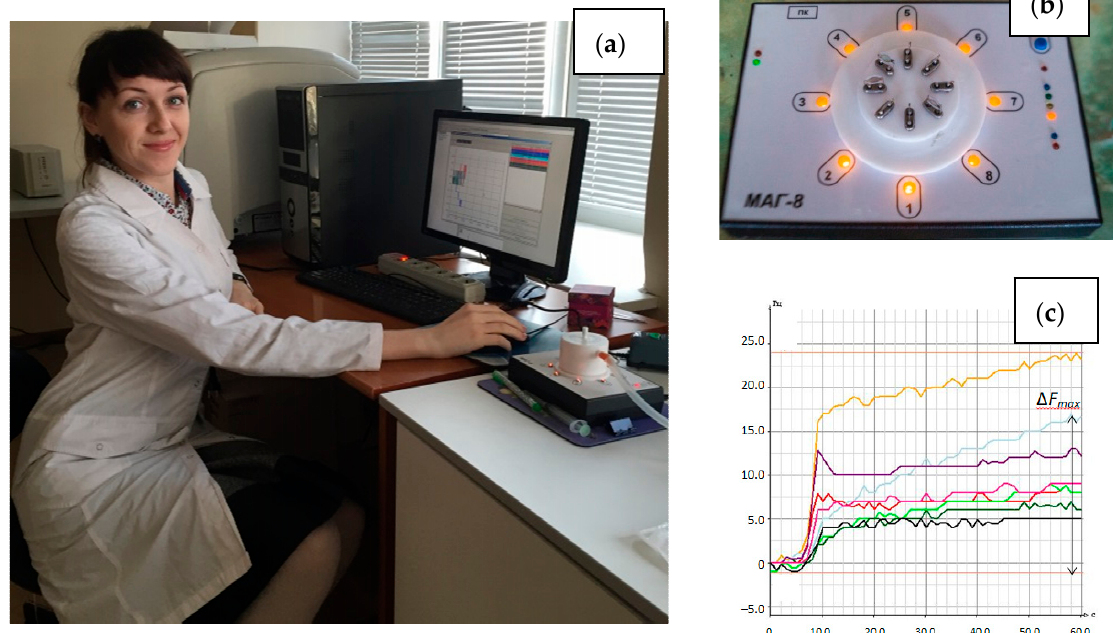
Figure 1. Photo of the MAG-8 device: ( a ) in the laboratory during analysis, ( b ) location of sensors in the detection cell; ( c ) chronofrequency grams of sensors during measurement.